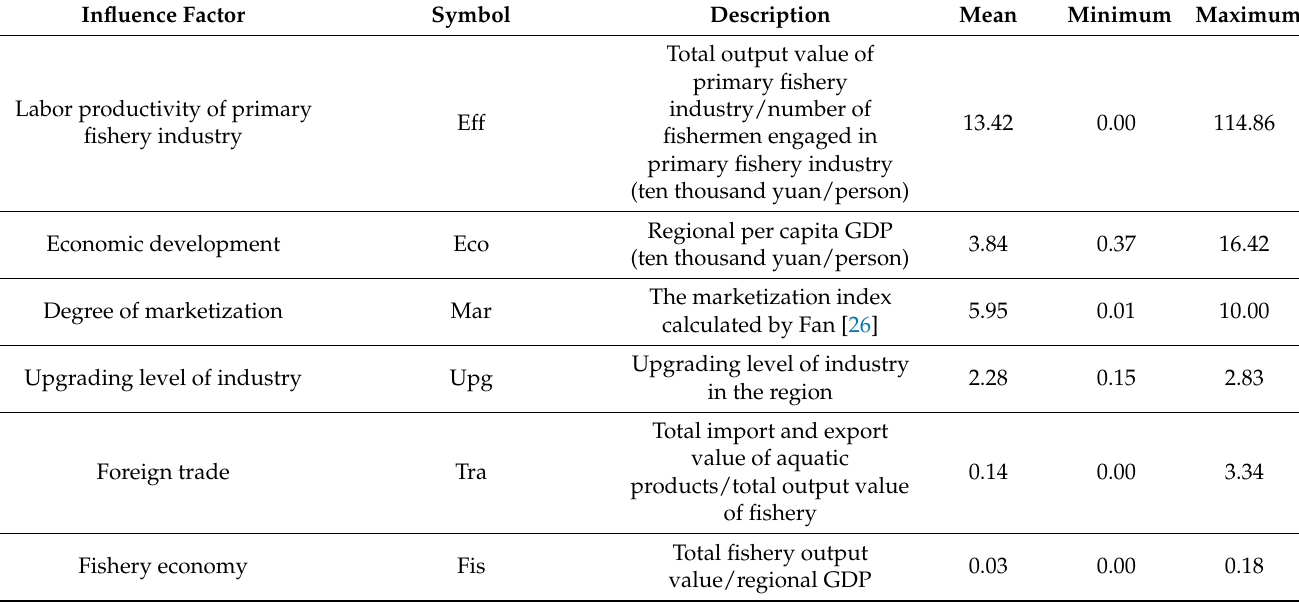
Table 1. Influencing factors of the upgrading level of fishery industrial